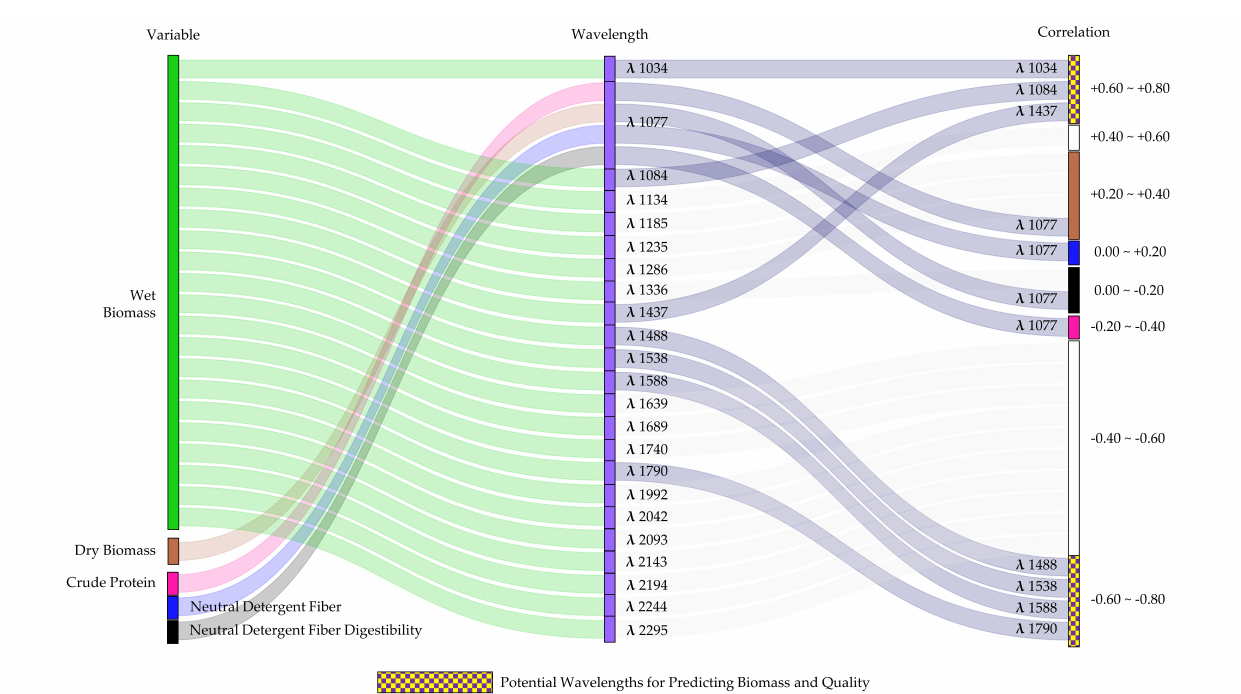
Figure A6. Sankey diagram illustrates the wavelengths in the short-wave infrared region ( λ 1000 − 2300) most correlated with alfalfa biomass and quality traits. The flow chart intuitively displays bars and paths drawn in proportion to the amount of information used. The larger the bars, the more times this information has been used. Colored pathways assign the connections between alfalfa biomass and quality traits and its usage in remote sensing data (i.e., wavelengths or vegetation indices) as well as its response to the strength of the correlation. When wavelength or vegetation indices have the potential to be used to establish a relationship with biomass and quality traits, they are marked. The colors of each correlation bar are linked to the biomass and quality traits. When it is white, it is because it has no potential to be used. However, when the bar is colored and checkered, it indicates that although it has not been used to study its relationship with quality, it has the potential to predict it assuming its correlation with